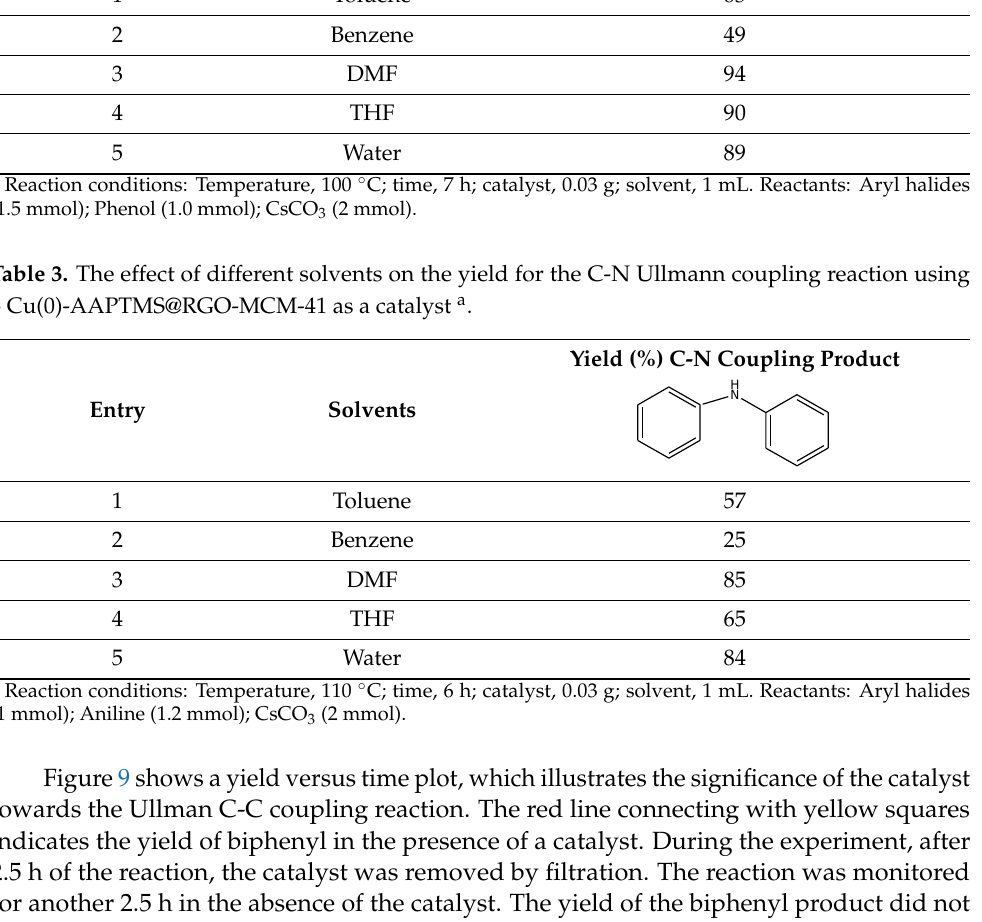
Table 4. Yields for C-C, C-O, and C-N coupling reactions with different substrates with 5 Cu(0)-